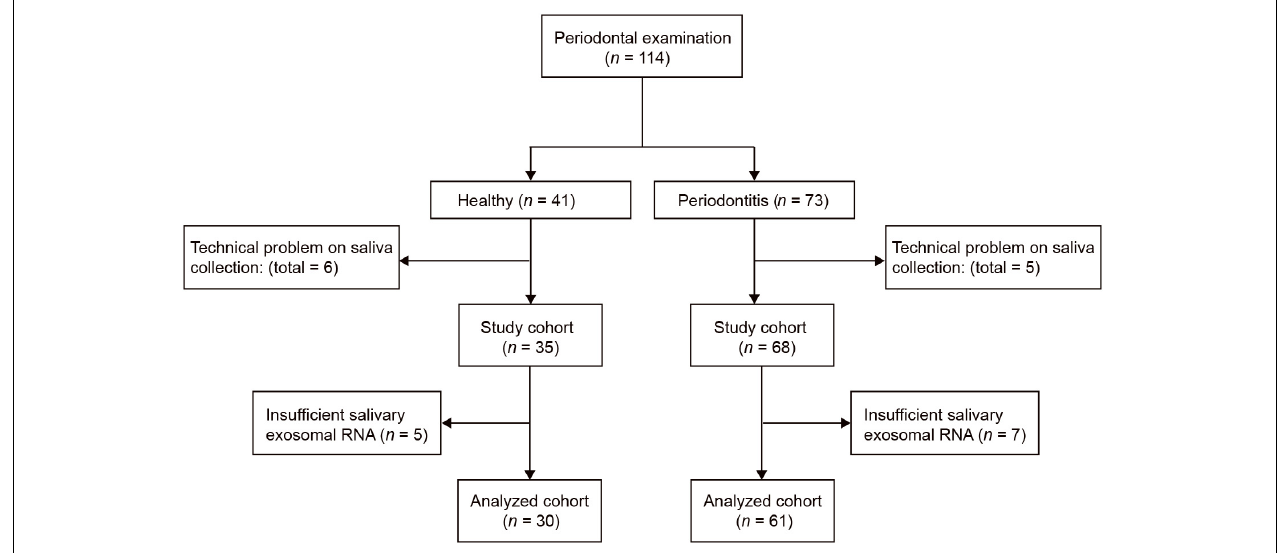
FIGURE 2 | Flow diagram of periodontitis patients and control subjects. Participant numbers are accounted for by the flow diagram for the study.